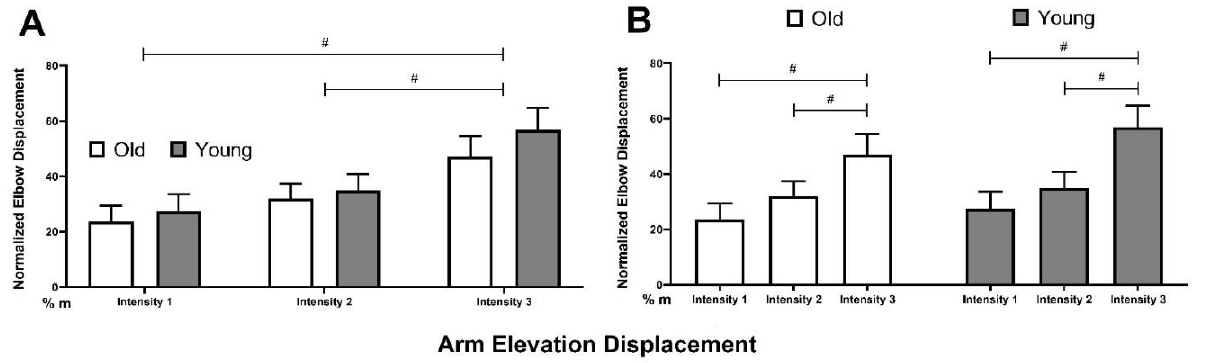
Figure 3. Maximal arm elevation displacement from perturbation onset to compensatory step touch down. # represents a difference between intensity levels, p < 0.05. Error bars display standard error. ( A ) Difference between two age groups at each perturbation intensity, ( B ) Difference between levels of perturbation intensity in each age group.